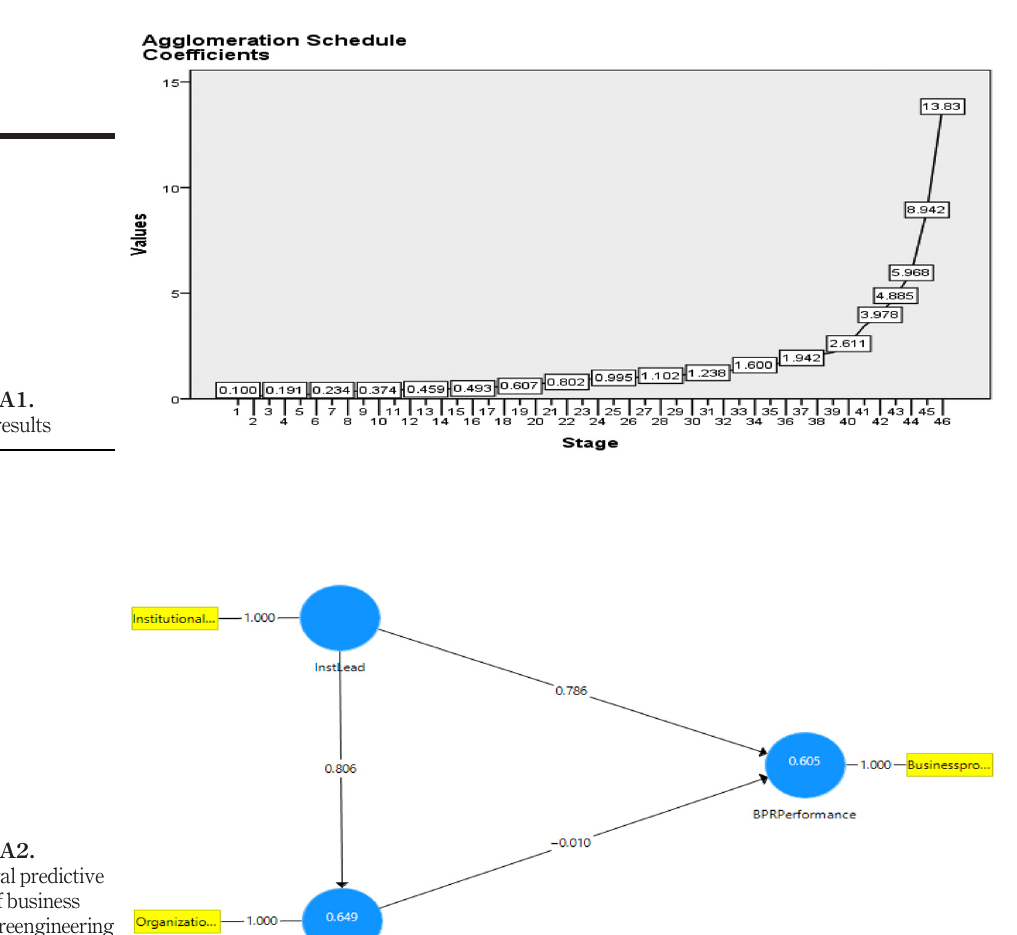
Figure A2. Structural predictive